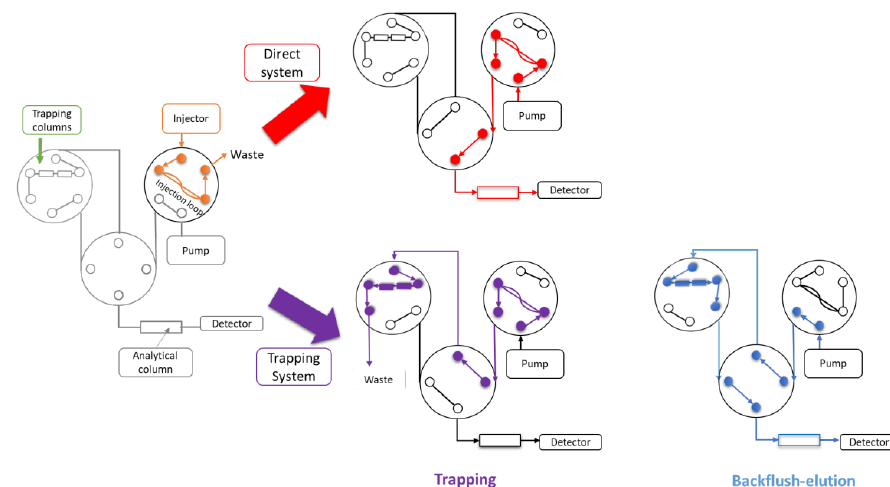
Figure 2. Schematic representation of the direct and trapping-LC